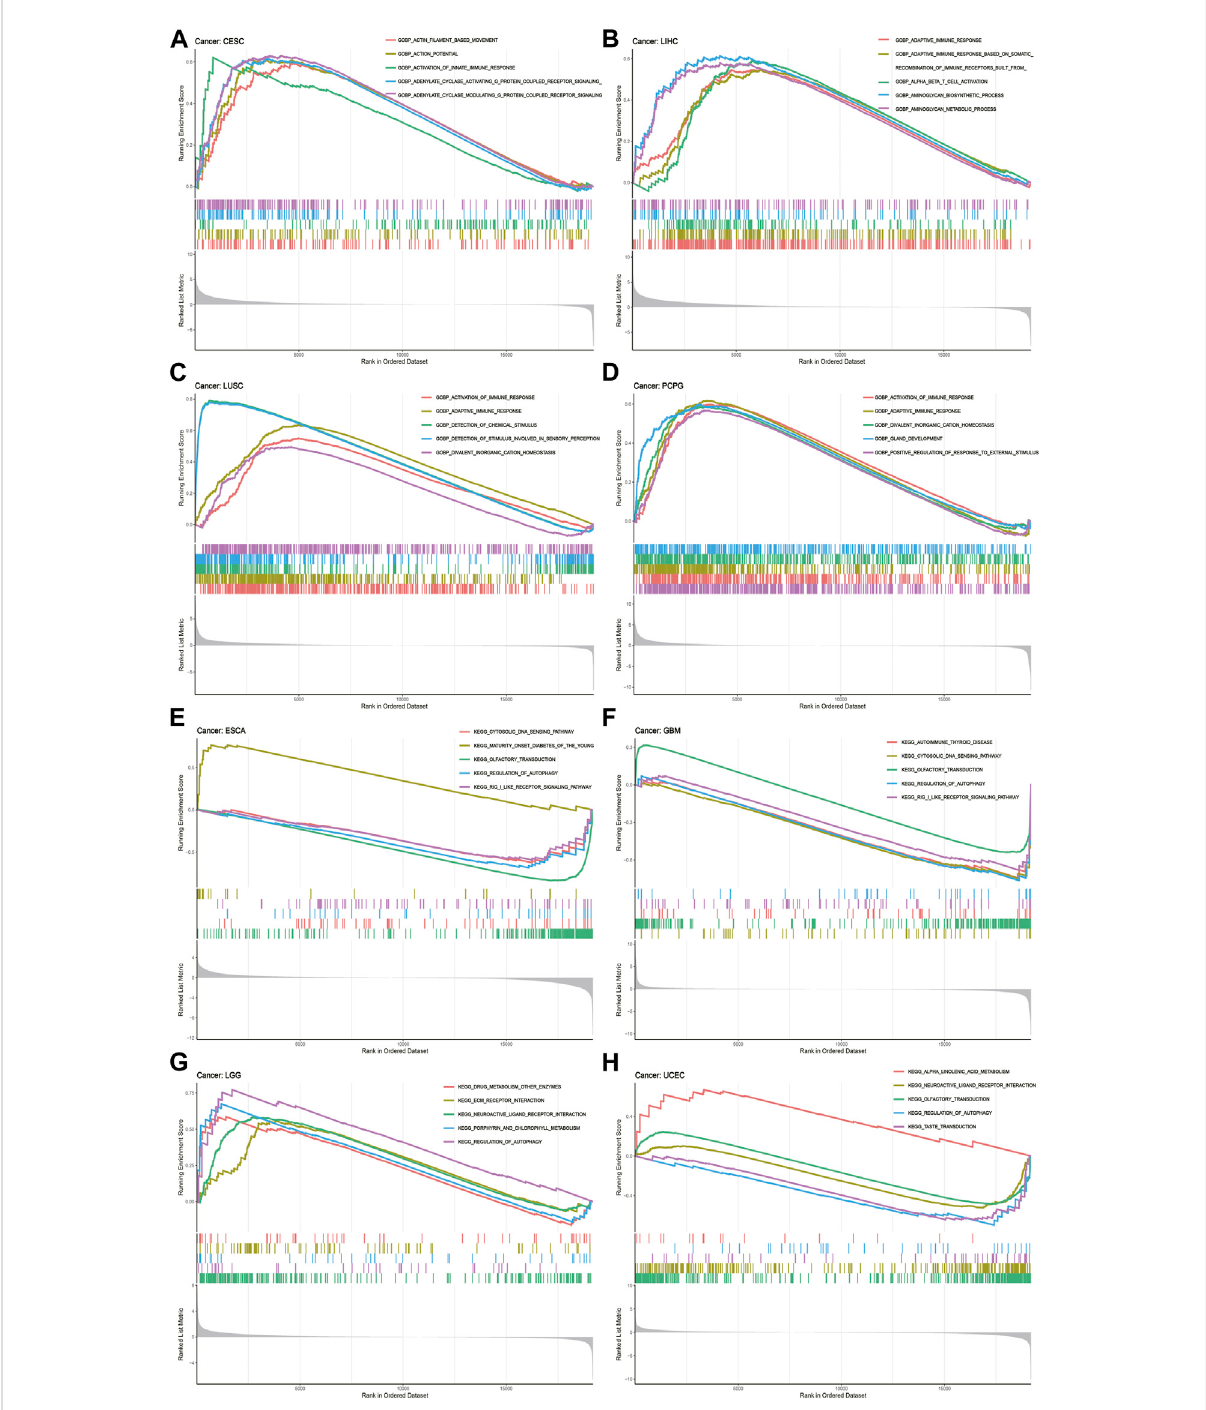
FIGURE 8 GSEAofCREB3L1. (A – D) GOfunctionalannotationofCREB3L1showstheactivationofinnateimmuneresponseinCESC,andadaptiveimmune response in LIHC, LUSC, and PCPG. (E – H) KEGG pathway analysis of CREB3L1 shows that regulation of autophagy was the most common signaling pathwayofCREB3L1participatinginTCGApan-cancer,includingUCEC,LGG,GBM,andESCA.Curvesofdifferentcolorsshowdifferentfunctionsor pathways regulated in different cancers. Peaks on the upward curve indicate positive regulation and peaks on the downward curve indicate negative